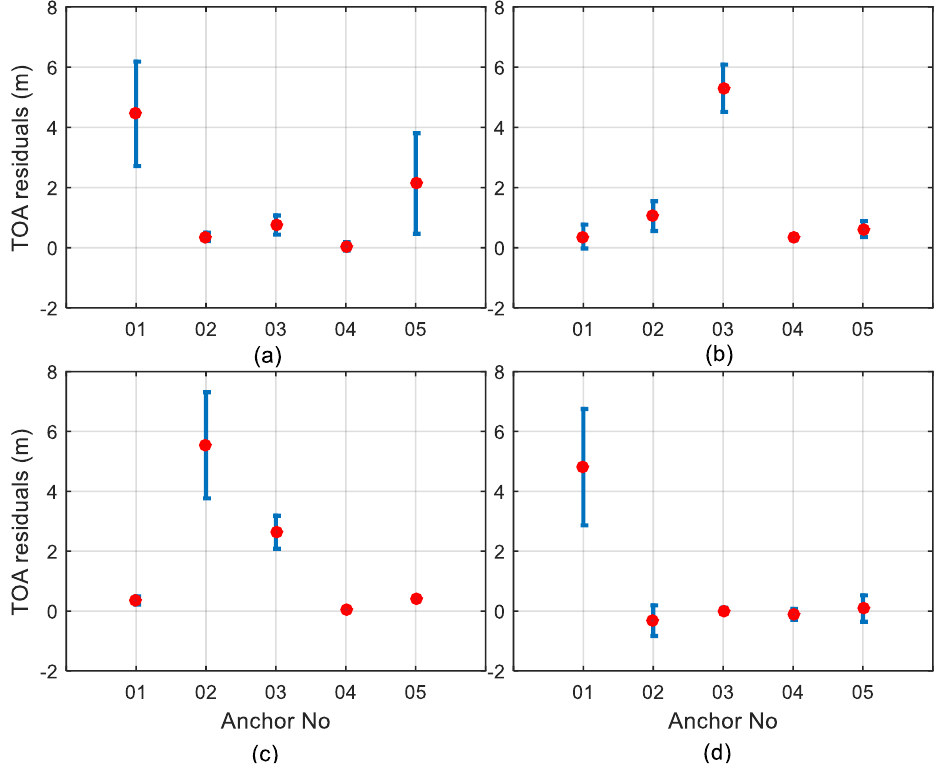
Figure 16. The mean value (red dots) and standard deviation (blue bar) of the TOA residuals subject to the truth. (a):MS 1 (b):MS 2 (c):MS 3 (d):MS 4.